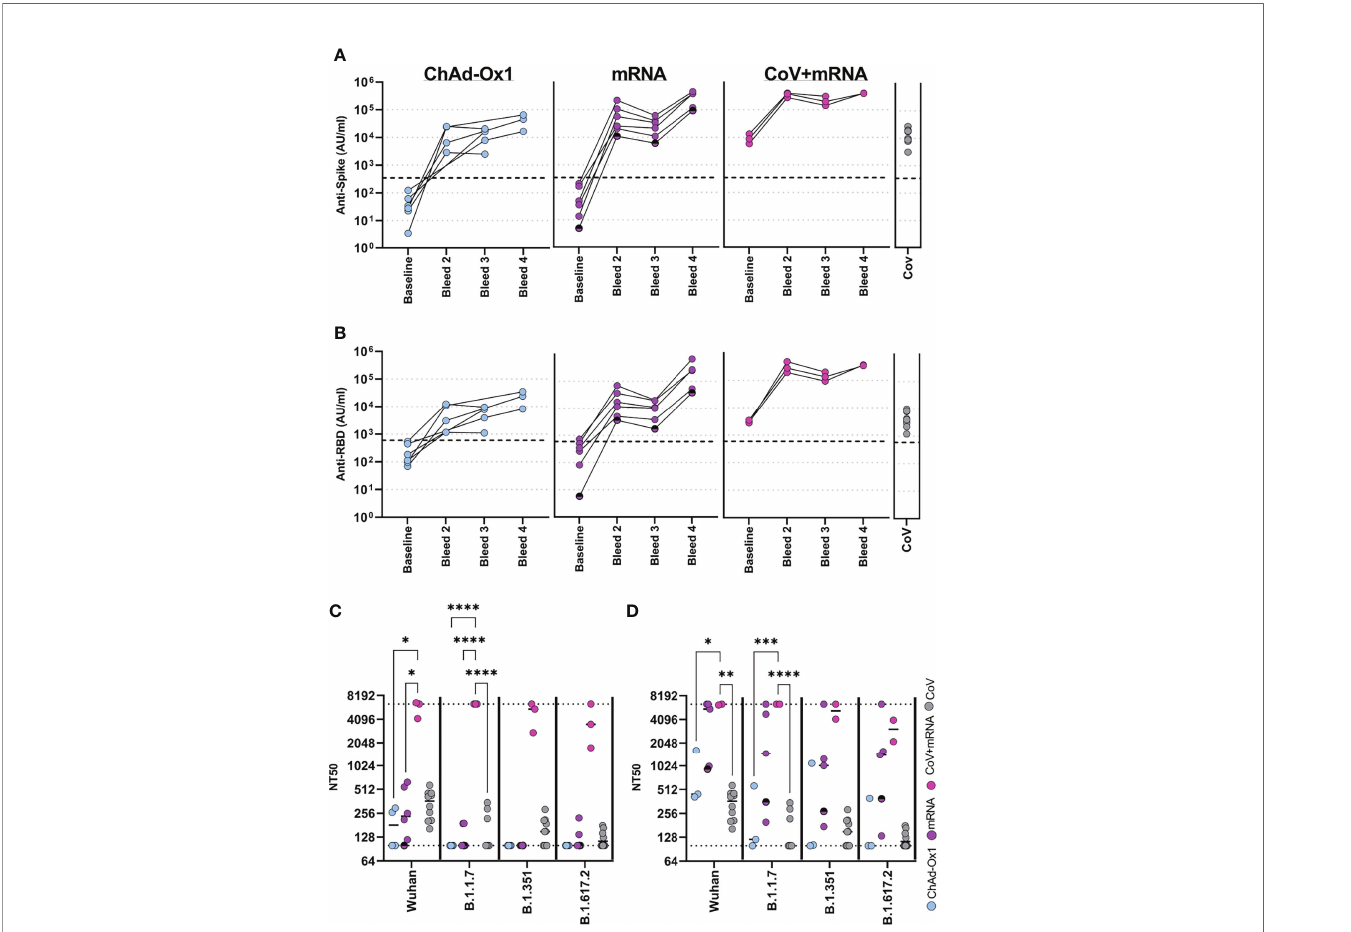
FIGURE 2 | Antibody responses in adolescents following COVID-19 vaccination. Antibody levels to Spike (A) and RBD (B) measured by MSD assay in adolescents receiving COVID-19 vaccination (ChAdOx1 – seronegative adolescents receiving ChAdOx1 vaccination, (n = 6), mRNA – seronegative adolescents receiving mRNA vaccination (n = 6), CoV+mRNA – seropositive adolescents receiving mRNA vaccination (n = 3), half shaded mRNA symbol indicates the individual who received BNT162b2 vaccine). Antibody levels 2-4 months after natural SARS-CoV-2 infection [CoV, (n = 10)] are shown for comparison. (C , D) Neutralisation of live virus, either B (Wild Type; PHE-2), B.1.1.7 (Alpha), B.1.351 (Beta) or B.1.617.2 (Delta) variants, following fi rst dose (C) or second dose (D) . Dotted lines represent upper and lower limits of detection. RM Two-way ANOVA with Geisser-Greenhouse correction and Tukey ’ s multiple comparison test. *p<0.05, **p<0.01, ***p<0.001,